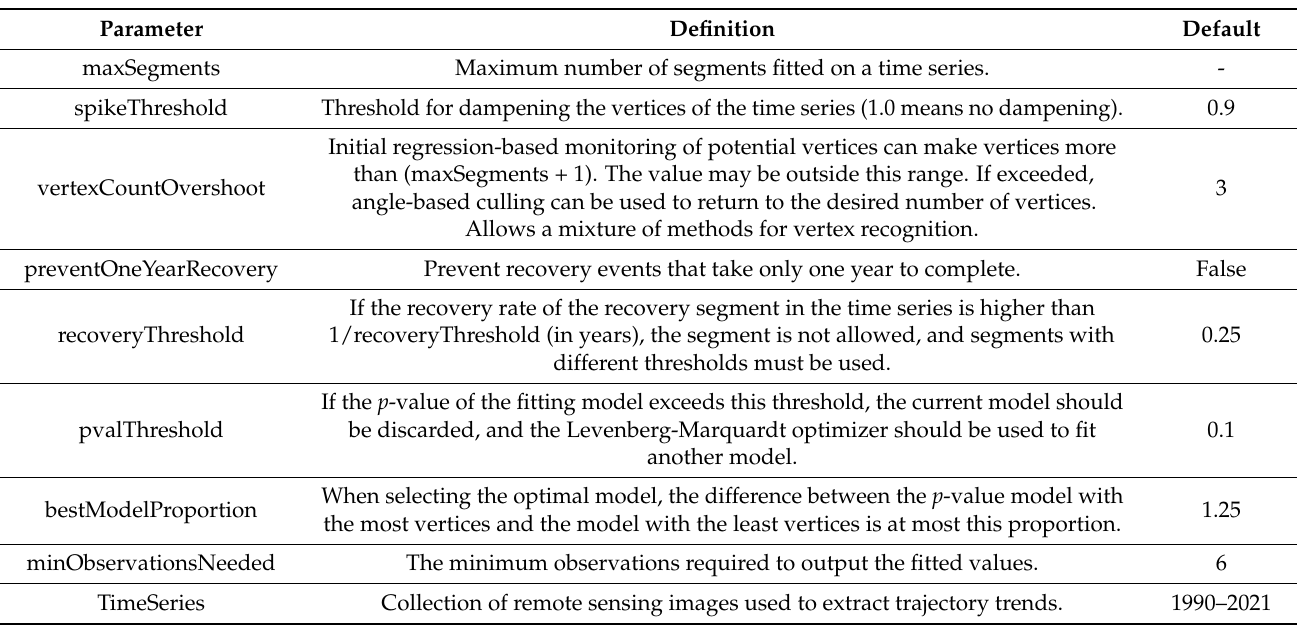
Table 2. LandTrendr parameters (Quote from LT-GEE